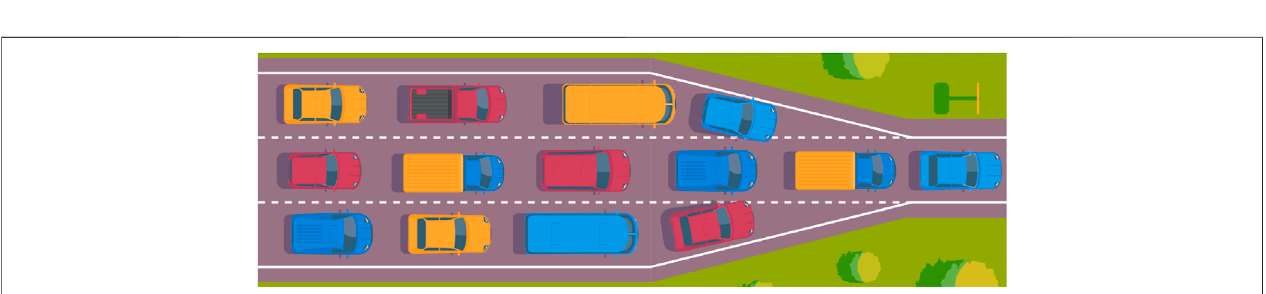
FIGURE 5 | A visualization of the bottleneck phenomenon in real network.